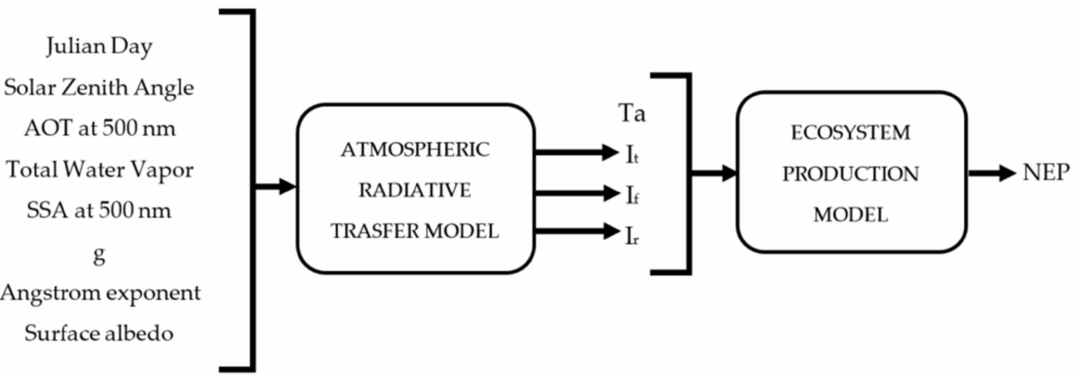
Figure 2. The calculation’s chart flow. AOT—aerosol optical thickness, SSA—single scattering albedo, g—asymmetry parameter, Ta—air temperature, I t —total PPFD, I f —diffuse PPFD, I r —direct PPFD, NEP—net ecosystem